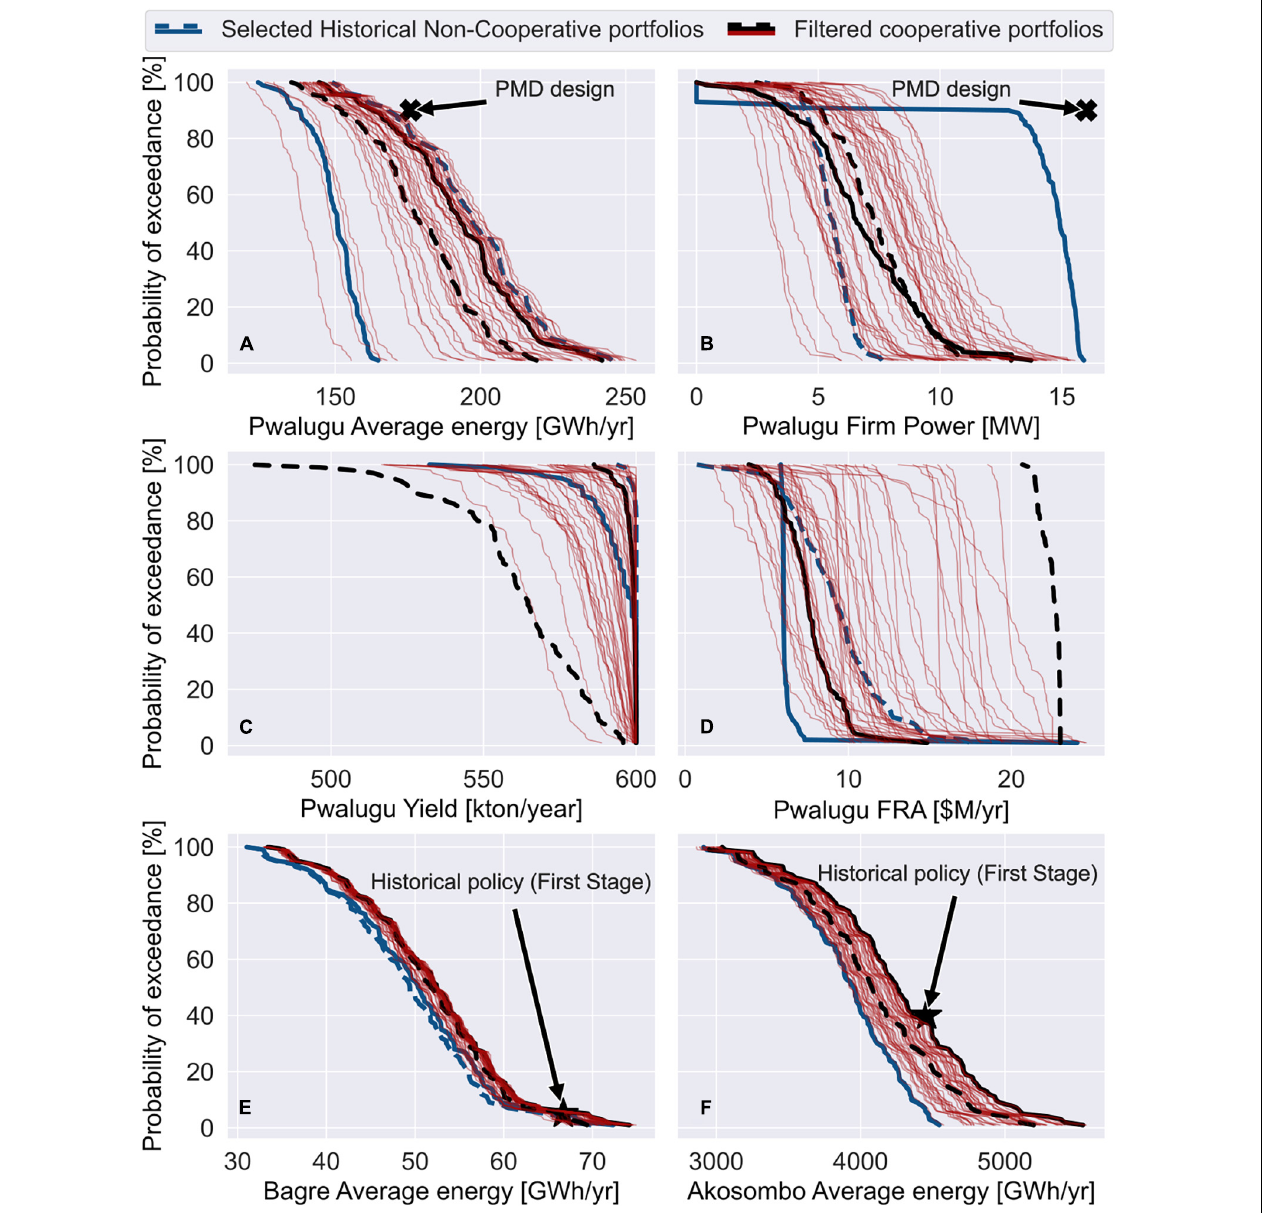
FIGURE 6 | Probability of exceedance curves for different metrics in the system. Panel (A) shows the Pwalugu Average energy, panel (B) shows the Pwalugu Firm Power, panel (C) shows the Pwalugu Irrigation Yield, panel (D) shows the Pwalugu Flood Recession Agriculture (FRA), panel (E) shows the Bagre Average energy, and panel (F) shows the Akosombo Average energy. The PMD average energy and firm power design (Volta River Authority, 2018) is displayed in panels (A,B) , respectively.